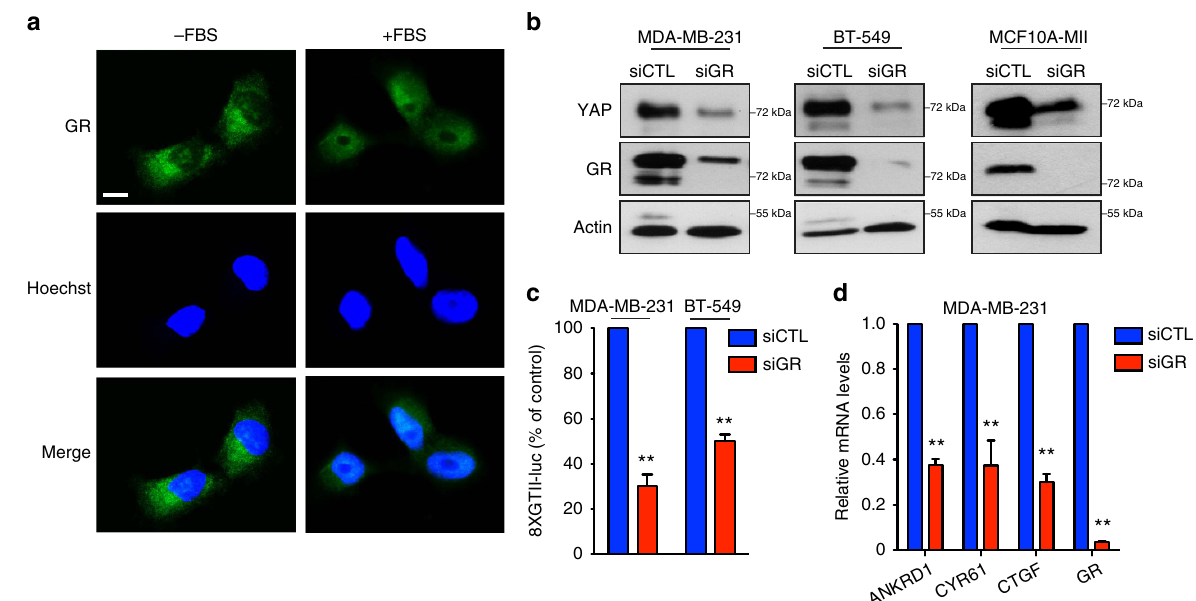
Figure 2 | Glucocorticoid receptor controls YAP activity in breast cancer cells. ( a ) Representative images of immunofluorescence in MDA-MB-231 cells. Cells were serum starved or grown in 10% FBS for 24h. Experiment repeated three times. Scale bars, 15 m m. ( b ) MDA-MB-231, BT-549 and MII cells were transfected with control (siCTL) or glucocorticoid receptor (siGR) siRNA for 48h. Representative blots are shown. Experiment repeated three times. ( c ) MDA-MB-231 and BT-549 cells were transfected with control (siCTL) or glucocorticoid receptor (siGR) siRNA. The day after, cells were transfected with 8XGTII-luc reporter. After 24h cells were collected. Data are normalized to siCTL. Error bars represent mean ± s.d., from n ¼ 3 biological replicates. ( d ) Quantitative PCR with reverse transcription analysis of MDA-MB-231 transfected with control (siCTL) or glucocorticoid receptor (siGR) siRNA for 48h. Error bars represent mean ± s.d., from n ¼ 3 biological replicates. * P o 0.05, ** P o 0.01; two-tailed Student’s t -test is used